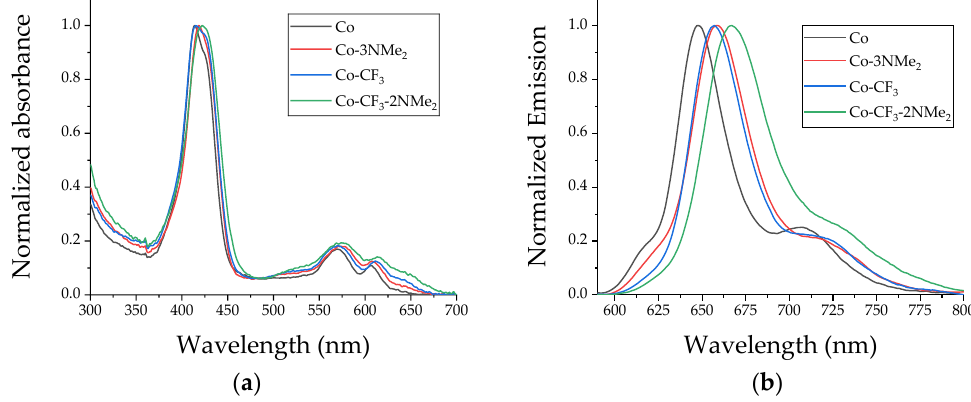
Figure 1. Spectroscopic studies of the four corroles in toluene at room temperature: ( a ) normalized absorption spectra; ( b ) normalized steady-state emission spectra. Co (black line), Co-3NMe 2 (red line), Co-CF 3 (blue line), and Co-CF 3 -2NMe 2 (green line).